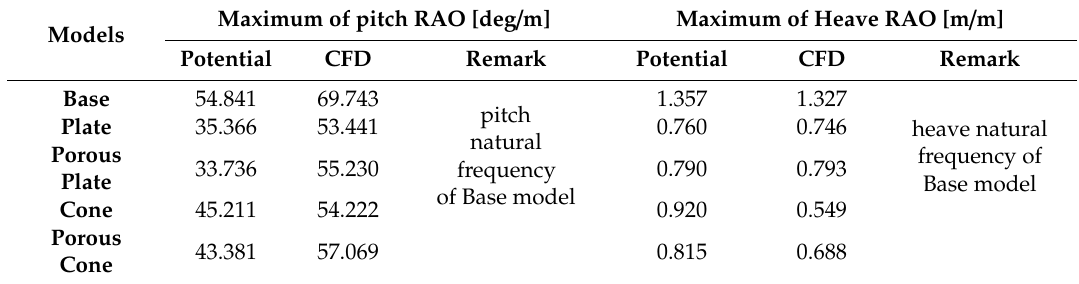
Figure 20. Comparison of ( a ) pitch and ( b ) RAOs between the CFD simulation and potential-based motion analysis. Table 6. Comparison of maximum RAOs estimated from the potential-based simulation with those from the CFD simulation.